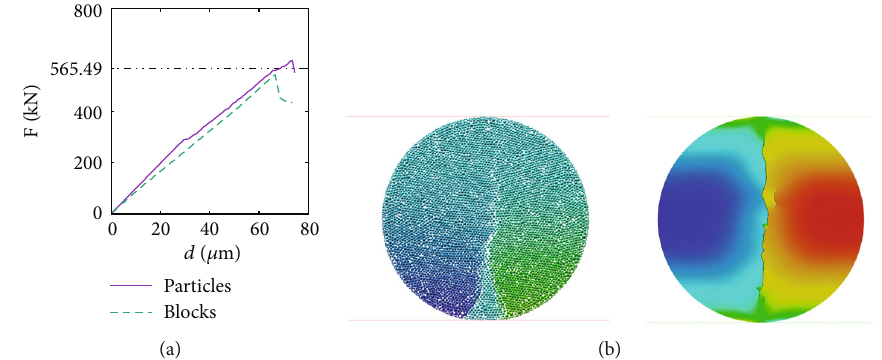
Figure 2: The results of the Brazilian disk test: (a) force-displacement curves; (b) failure patterns.